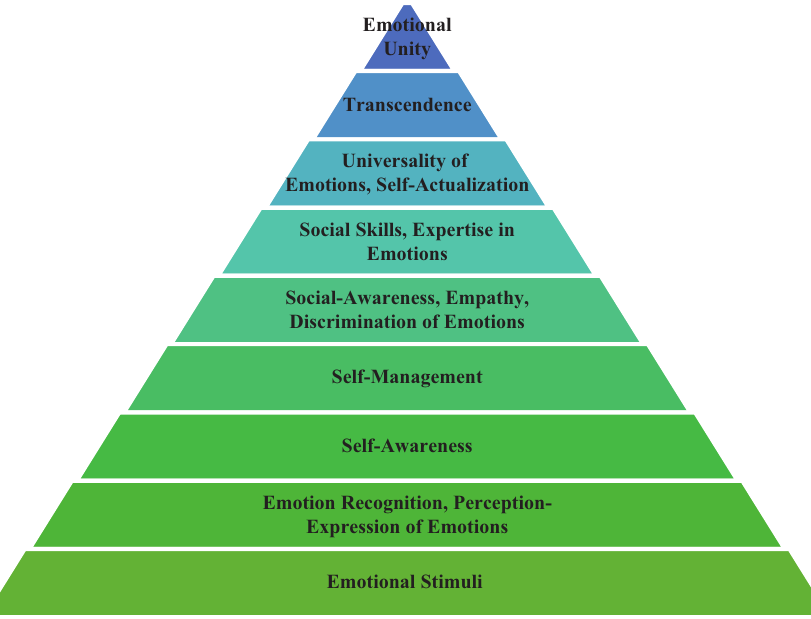
Fig. 1. The emotional intelligence pyramid (9-layer